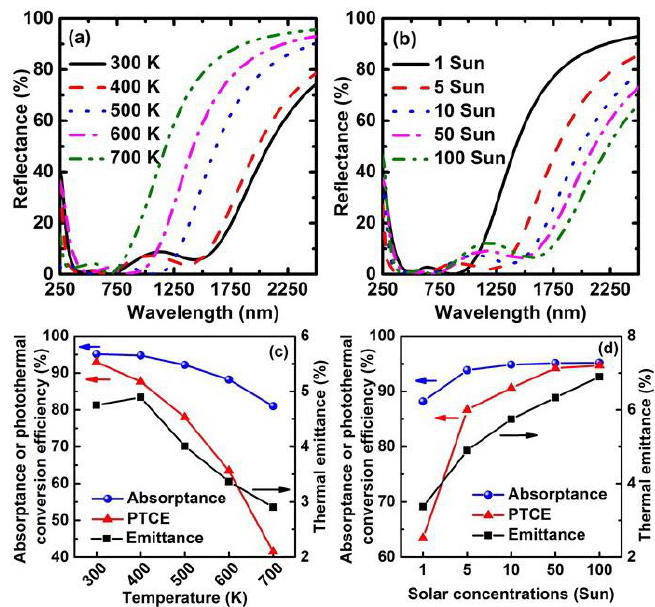
Figure 6. Reflectance spectra of the six-layer solar selective absorbers: ( a ) working temperature at 300, 400, 500, 600, and 700 K with solar concentration at 1 Sun; ( b ) working at 1, 5, 10, 50, and 100 Suns with the temperature at 600 K; influences of ( c ) temperatures (1 Sun), and ( d ) solar concentrations (600 K) on the performances of the six-layer solar selective absorbers.